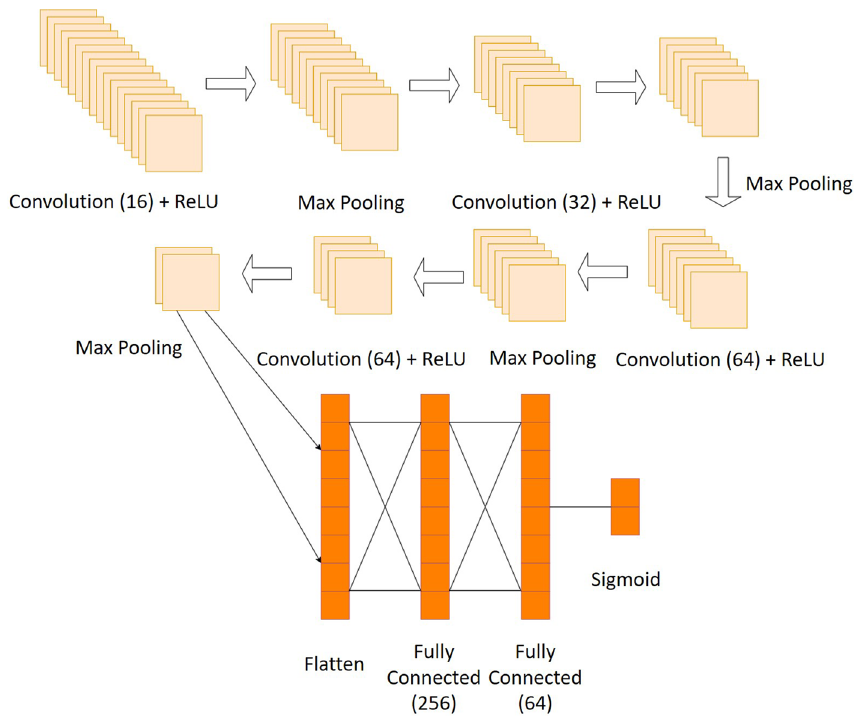
Figure 3. Summary of CNN model architecture for the binary problem. A 4-layer convolution network has been used with 16, 32, 64, and 64 3 × 3 × 3 sized filters each. The activation function for each convolution layer is a rectified linear unit (ReLu) 41 along with a 2 × 2 × 2 sized max pooling (feature aggregating) layer. The output from the hidden convolution layers is flattened, after which there are two fully connected (dense) layers with 256 and 64 units (for the final layer) respectively. The final activation layer is a sigmoid function 42 returning the 2-class membership probabilities as output. The optimizer used for the model is Adam 43 with a step size of 0.0001, and the loss function used is binary cross-entropy 44